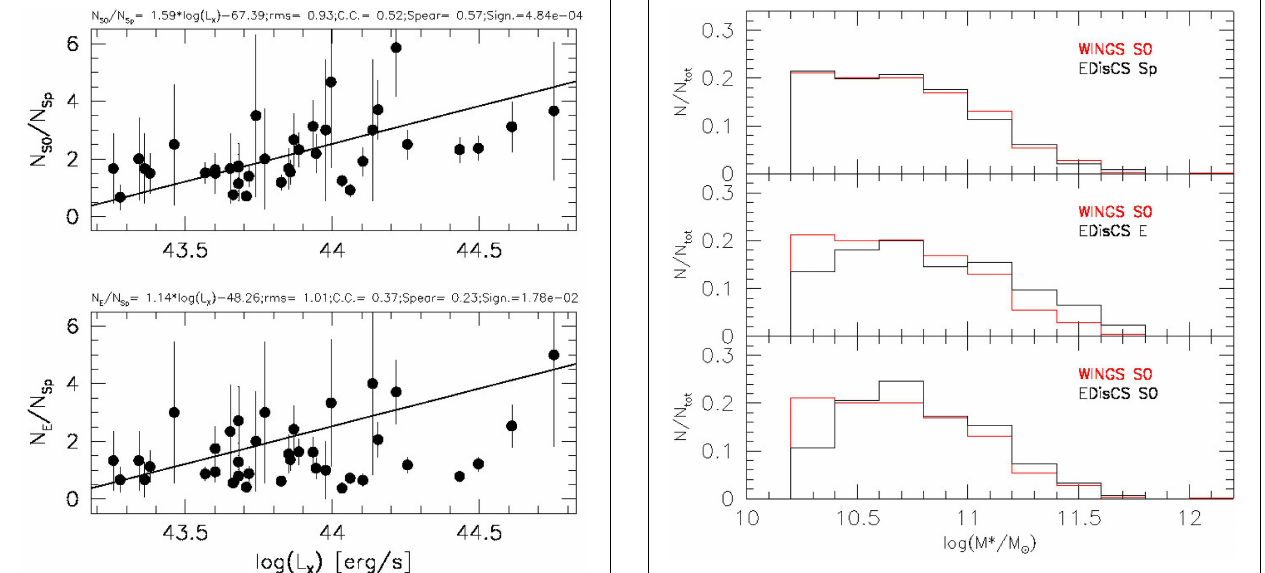
FIGURE 12 | The panel shows the X-ray luminosity of the WINGS clusters plotted against the morphological fractions S0/Sp (upper panel) and E/Sp (lower panel). Poissonian error bars have been assumed.